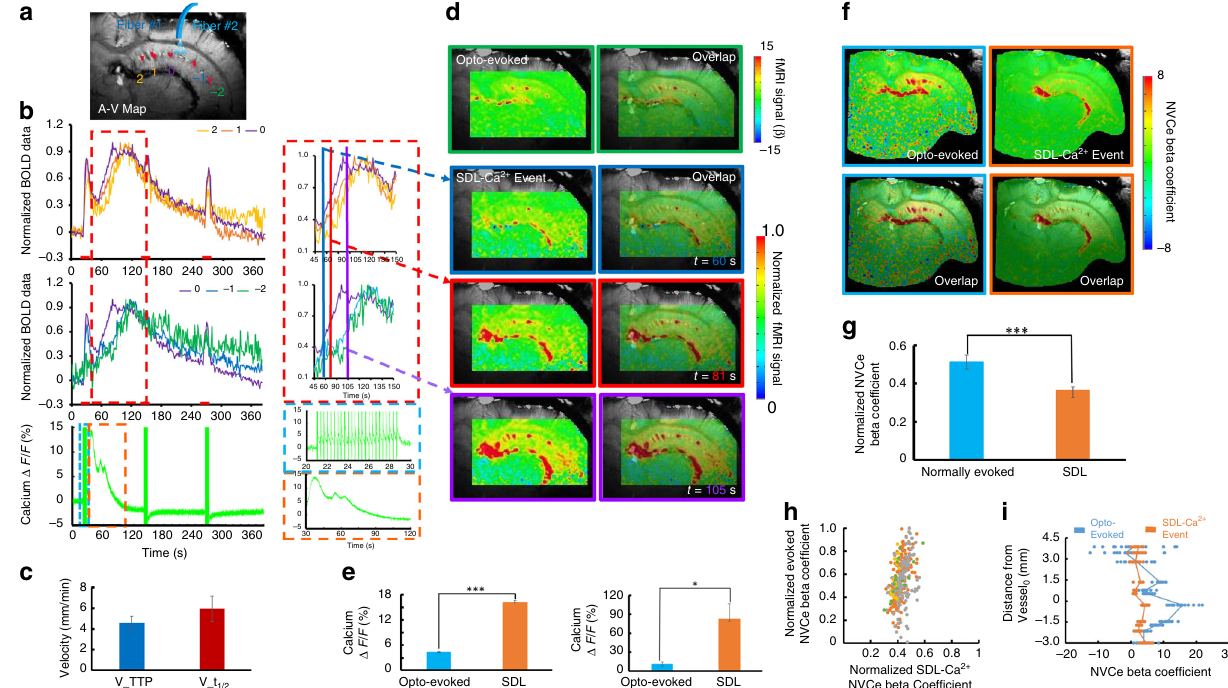
Fig. 5 Ca 2 + -based NVCe mapping. a Numbered venules on the A – V map. Venule 0 (purple) is the one closest to the optical fi ber tip, venules 1, 2 and − 1, − 2 are vessels with different directions in the hippocampal structure. b Time courses of normalized single-vessel BOLD fMRI signal from individual venules, as shown in Fig. 4a, are plotted (top) with the concurrent neuronal Ca 2 + signal (bottom). Insets are the magni fi ed fi gures of the dashed box in the left to highlight the SDL-Ca 2 + events and coupled single-vessel BOLD responses (illumination: 10 ms light pulse, 3 Hz, 8 s, 5 mW). c Velocity of SDL-Ca 2 + events spreading between different hippocampal venules with different time to peak (TTP) and t 1/2 (18 vessels from 3 rats, mean ± SEM). d Representative color-coded BOLD fMRI map (optogenetically evoked) from the hippocampus (upper). Time-lapsed function maps and semi-transparent overlapping images on the A – V map at 60 s (blue box), 81 s (red box), and 105 s (purple box) during the trial. e Amplitude of optogenetically evoked Ca 2 + signals is signi fi cantly lower than that of SDL-Ca 2 + spikes in the hippocampus (left: * p = 6.22e − 11, 10 trials from a representative rat; right: * p = 0.028, n = 4 rats). f NVCe coef fi cient map for both optogenetically evoked and SDL-Ca 2 + events. g Z -score normalized NVCe coef fi cients of optogenetically evoked events are signi fi cantly higher than those of SDL-Ca 2 + events ( n = 4 rats, * p = 0.003). h Scatter plot of z -score normalized NVCe coef fi cients from optogenetically evoked vs. SDL-Ca 2 + events from each trial in four representative rats. i Z -score normalized NVCe coef fi cients from individual vessels were plotted as a function of vessel distance for both optogenetically evoked and SDL-Ca 2 + events in a representative